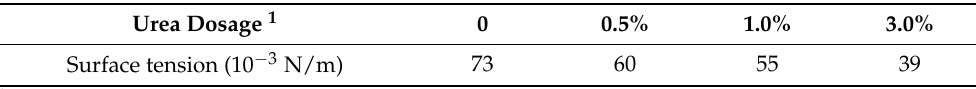
Figure 7. The ( a ) Bleeding rate ( B w ) and ( b ) slump flow ( D f ) of GBM slurry using CG-B obtained by grinding with urea. Table 2. The surface tension of deionized water and urea